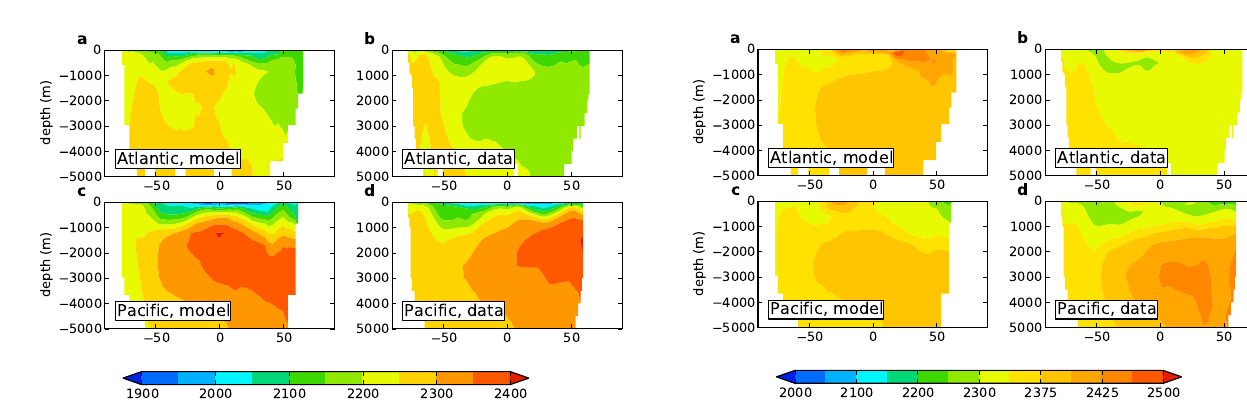
Figure 16. Zonal average of the alkalinity (ALK) distribution in the ocean (µmolkg − 1 ). Data from GLODAP (Key et al.,